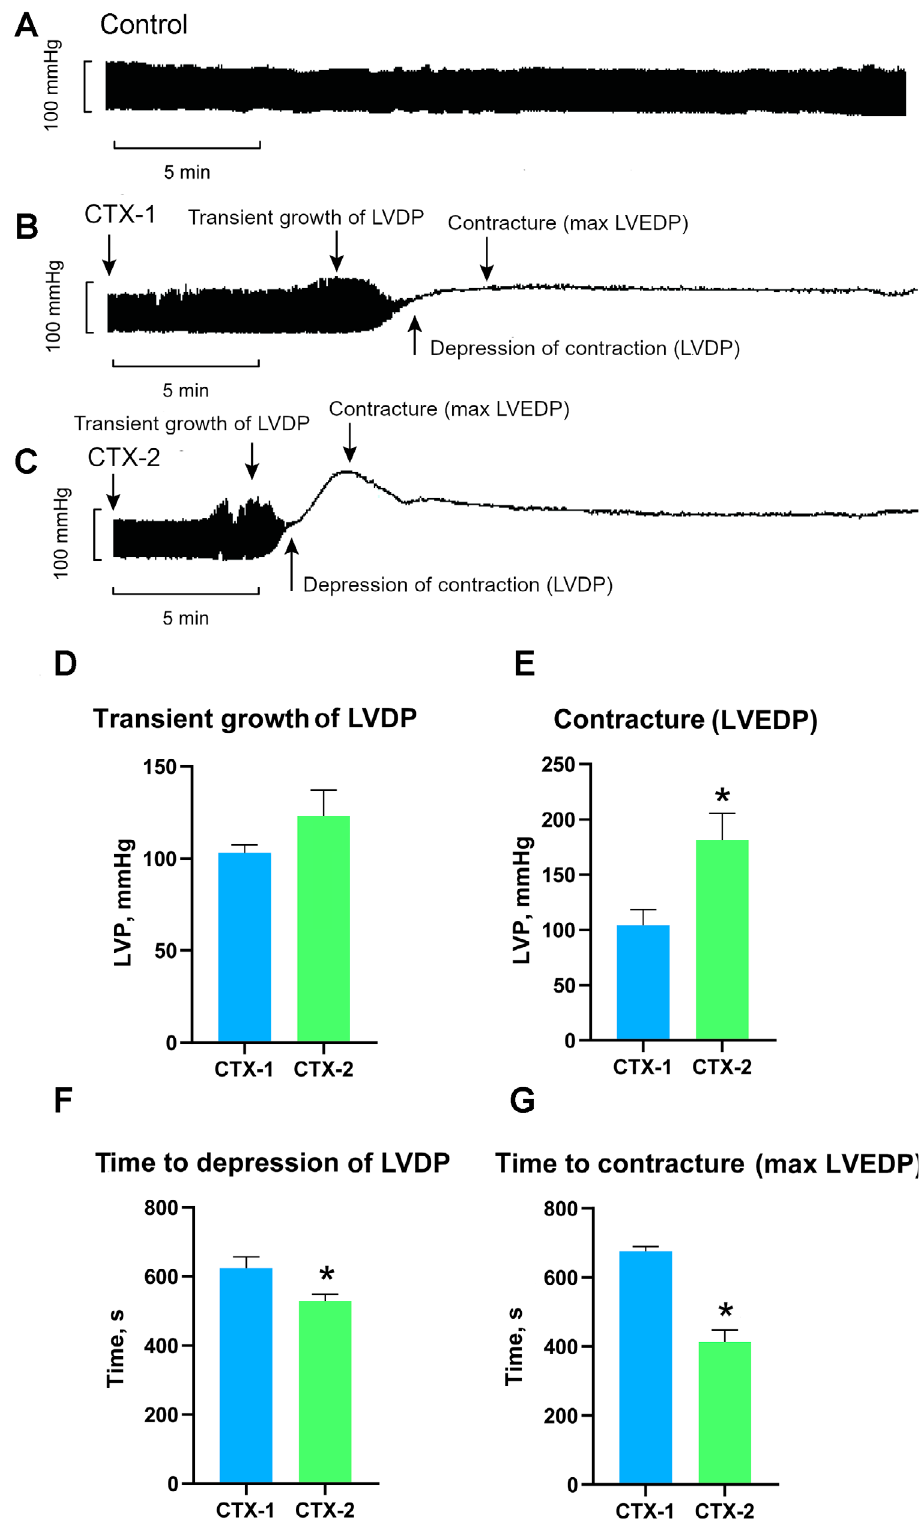
Figure 2. CaTX effects on the ventricular pressure parameters and effect development time. Representative traces of (A) untreated control and the effect of (B) CTX-1 and (C) CTX-2 at the concentration of 5 μg/mL on the contractile activity of the heart. (D) The magnitude of the temporary increase in LVDP and the maximum of (E) the developed contracture of the heart under the influence of CaTXs. The time required for complete suppression of contractile activity (F) in the left ventricle and (G) for reaching the maximum of LVEDP. CTX-1 (n = 6) and CTX-2 (n = 5). Data are presented as means ± standard error of the mean (* p < 0.05 compared to CTX-1 with unpaired two-tailed Student’s t